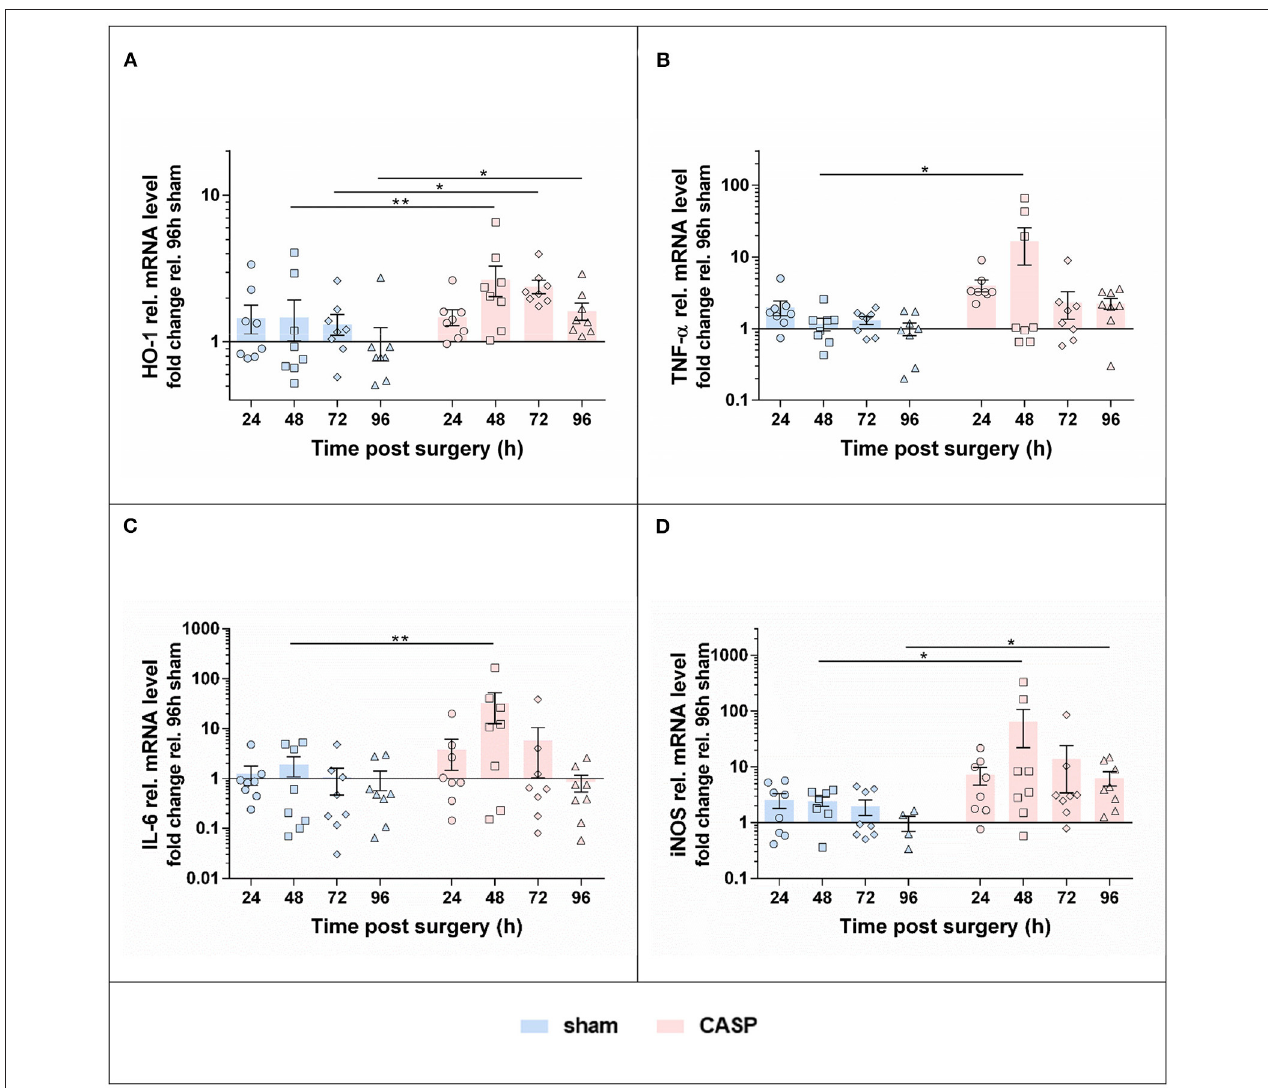
FIGURE 2 | Hepatic inflammatory response induced by abdominal infection peaks at 48h. Gene expression levels of (A) HO-1, (B) TNF- α , (C) IL-6, and (D) iNOS were determined using qPCR in liver samples of rats that underwent sham or CASP surgery. Data are shown as mean ± SEM, with n = 8 for all the groups, except for (D) sham 48h ( n = 7) and (D) sham 96h ( n = 4). Statistical differences were calculated using two-way ANOVA followed by uncorrected Fisher’s LSD test and are indicated by * p < 0.05; ** p <